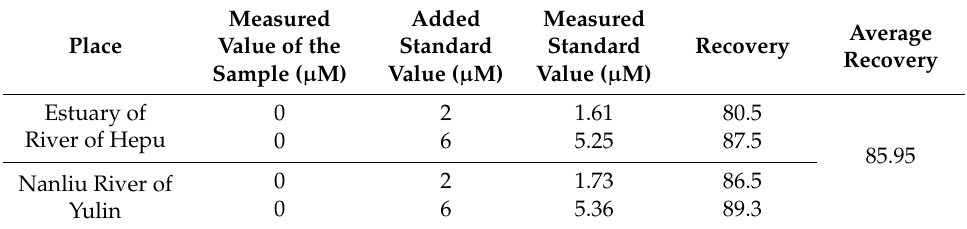
Table 1. Determination of water samples using this method.